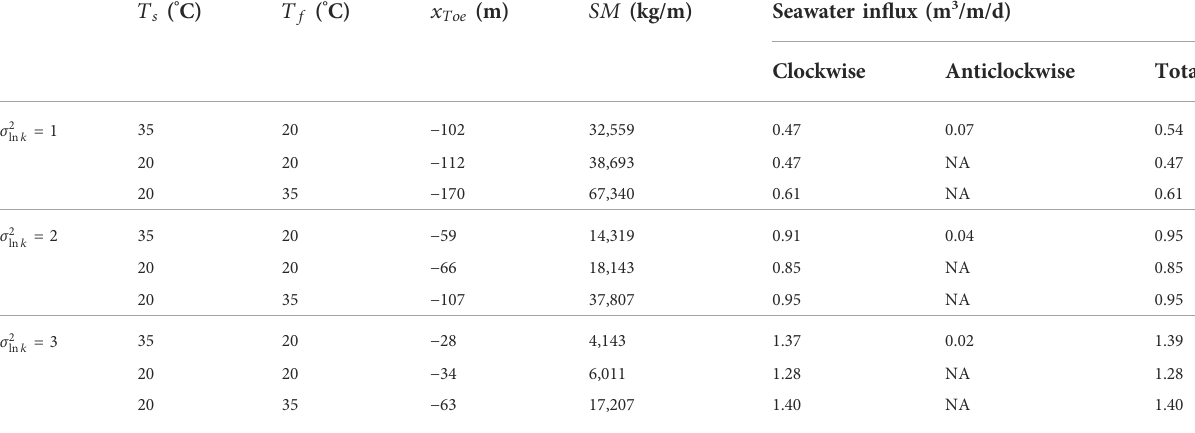
TABLE 2 Key results for heterogeneous cases with different permeability variances and FW-SW temperature contrasts. T s ( °